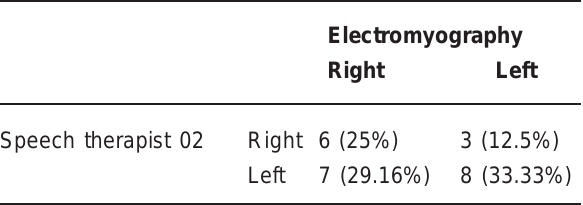
TABLE 2- Agreement between palpation of speech therapist 02 and EMG